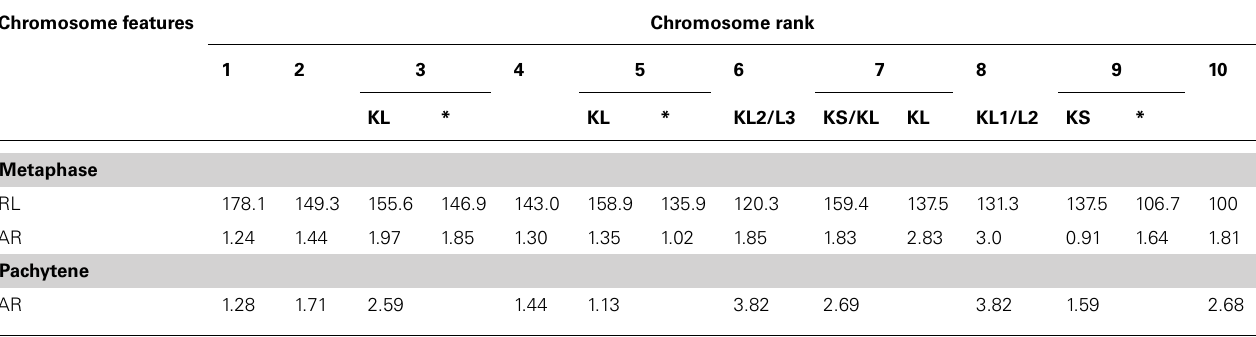
Table 2 | Relative lengths and arm ratios of somatic chromosomes and arm ratios of pachytene chromosomes in JD lines. K6L2/L3 and K8L1/L2 are detected as a single band in mitotic chromosomes. Chromosome features